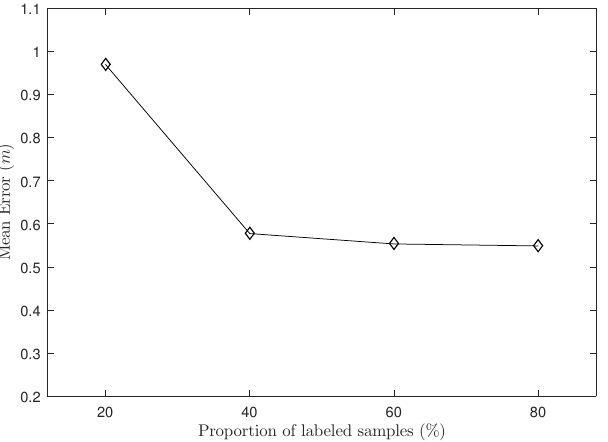
Figure 5. The Influence of Proportion of Labeled Samples.